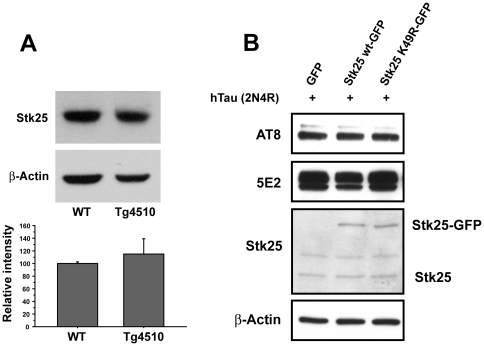
Stk25 expression is not correlated with augmented Tau phosphorylation in a Tauopathy model or in transfected HeLa cells.
A Lysates from brains of 9.5 month old wild-type or Tg4510 mutant animals were immunostained for Stk25 and β-actin (upper panel). The average Stk25 signal normalized to β-actin from 3 separate samples from each genotype showed no statistically significant difference (lower panel). B Overexpression of Stk25-GFP did not lead to increased phosphorylation of co-transfected Tau in HeLa cells. Antibodies used for Westerns indicated at left: AT8 (phospho Ser202/Thr205 Tau) 5E2 total Tau. Sizes of expected Stk25-GFP and endogenous Stk25 are indicated at right.